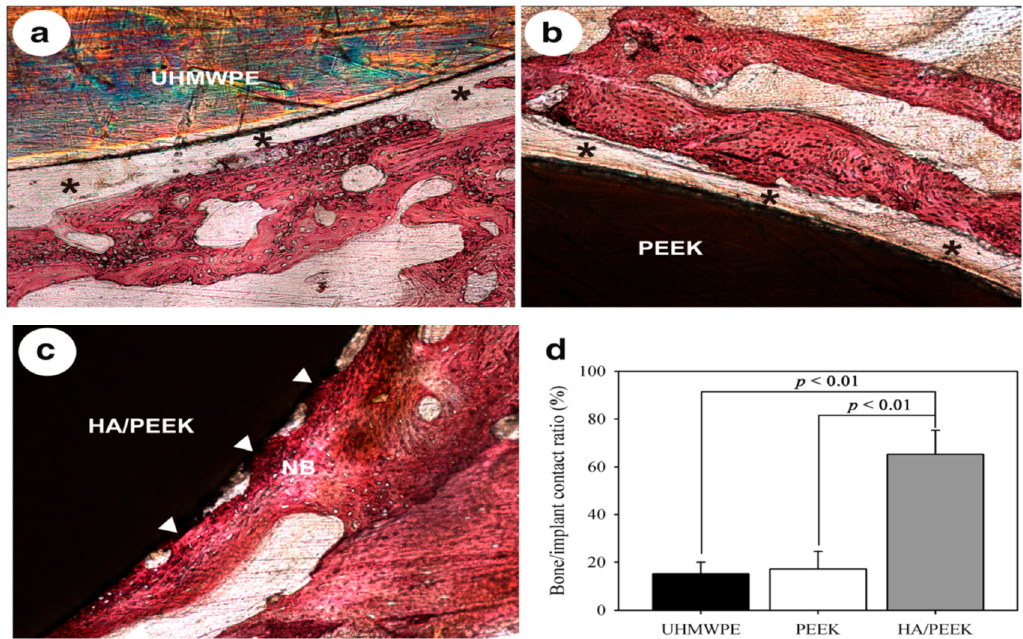
Figure 12. ( a ) Attachment of murine pre-osteoblastic cells (MC3T3-E1) and ( b ) ALP activity of osteoblasts cultured on different material surfaces for different time points. Reproduced from [135] with permission of BioMed Central under the terms of the Creative Commons Attribution 4.0